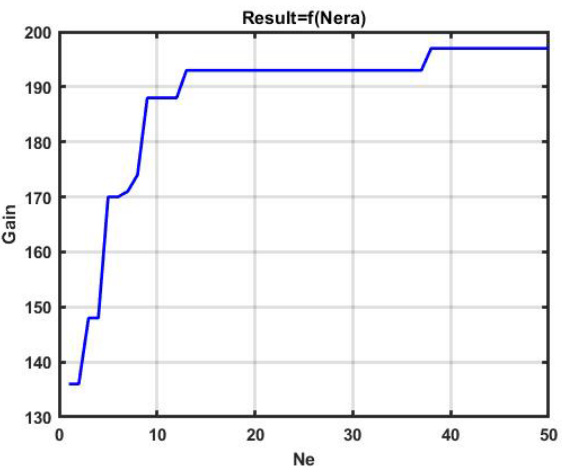
Figure 10. Effectiveness of the CSF strategy with evolutionary optimization for 10 epochs.